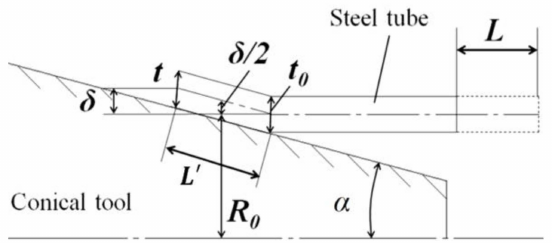
Figure 7. Schematic diagram of flaring test without consideration of bending radius when yield